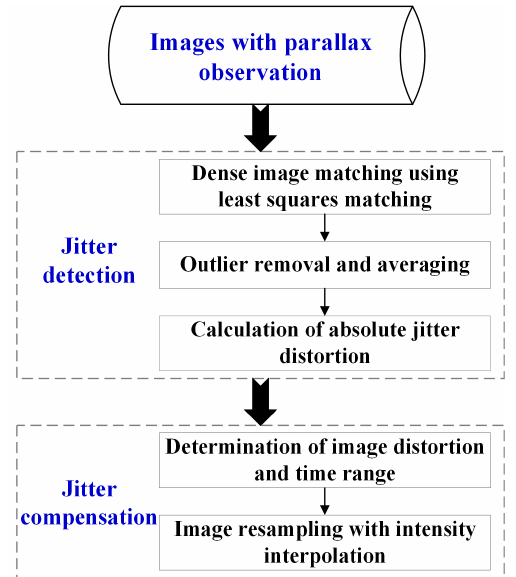
Figure 1. Overall workflow of jitter detection and